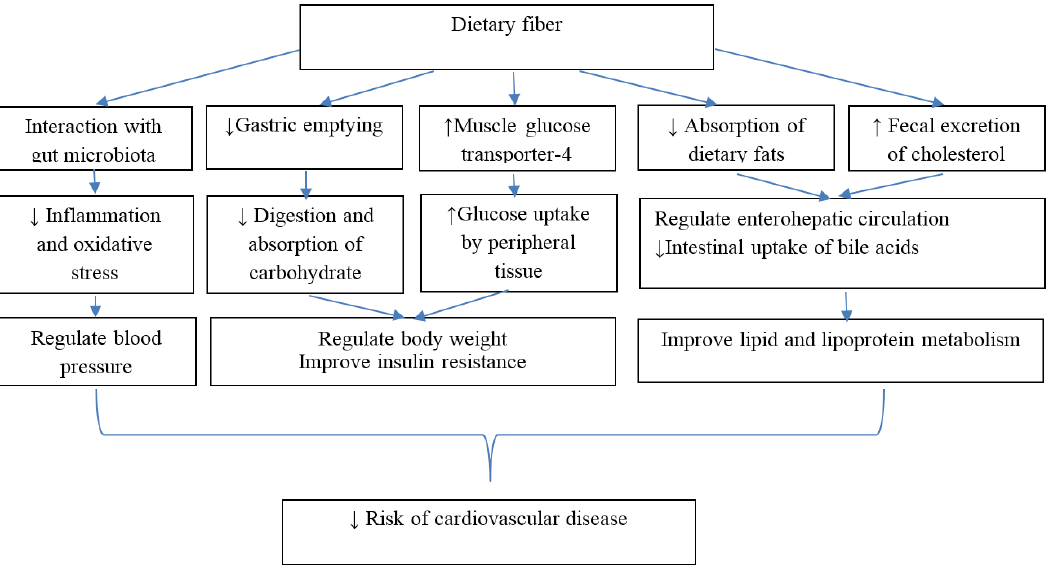
Figure 2. Mechanisms of protective effects of dietary fiber against development of cardiovascular disease. Dietary fiber improved insulin resistance by delaying gastric emptying, reduced absorption and digestion of carbohydrate and increased glucose uptake by peripheral tissue [34]. Dietary fiber also improved lipid and lipoprotein metabolism by decreased absorption of dietary fats, increased fecal excretion of cholesterol and decreased hepatic cholesterol synthesis; dietary fiber especially from cereal sources improved CVD health through multiple mechanisms including lipid reduction, body weight regulation, improved glucose metabolism, blood pressure control, and attenuation of oxidative stress and sub-clinical chronic inflammation [29]. Dietary fiber also modulated gut microbiota and modified cardiometabolic disorders [38–40].